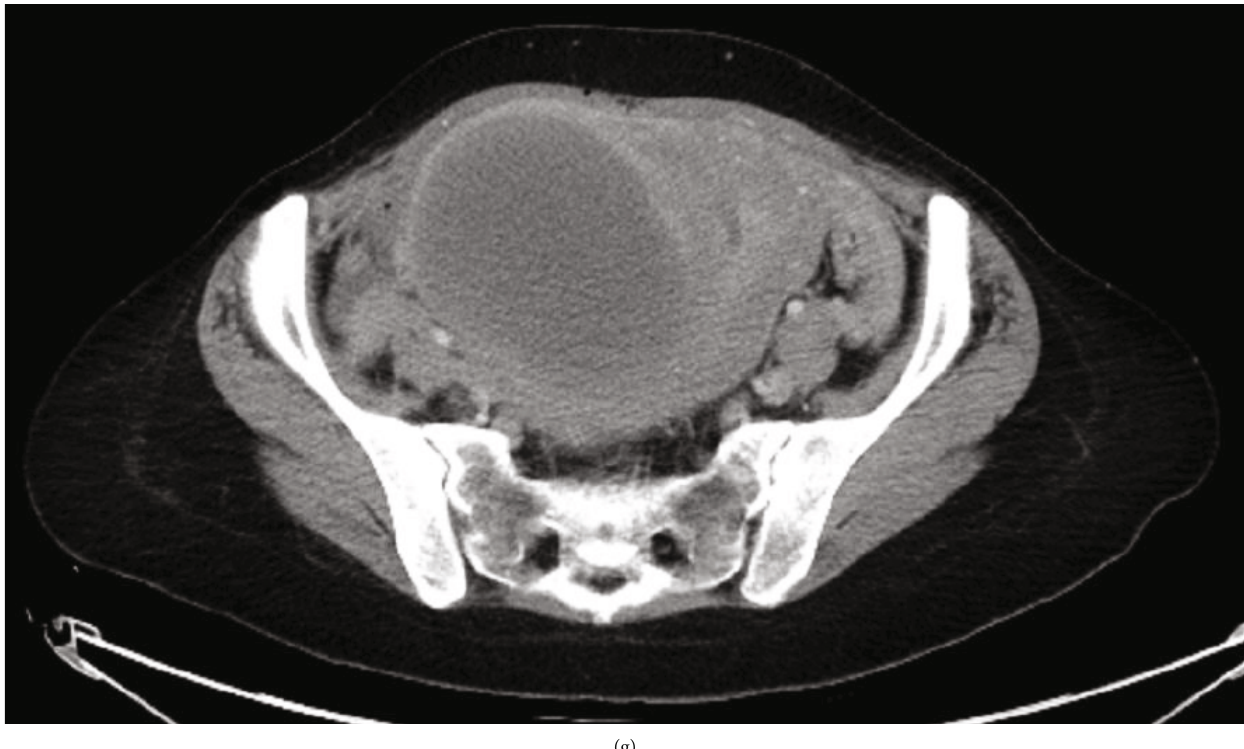
Figure 1: Follow-up of the (a – c) right renal vein to the (d – f) right ovarian vein. (g) No fl